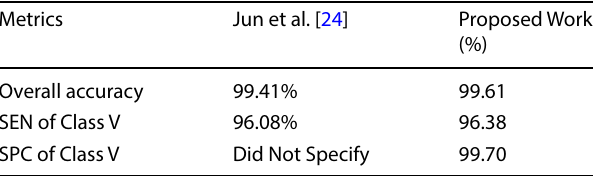
Table 5 Performance of other classifiers and our classifier on Patient Independent data for binary classes Metrics